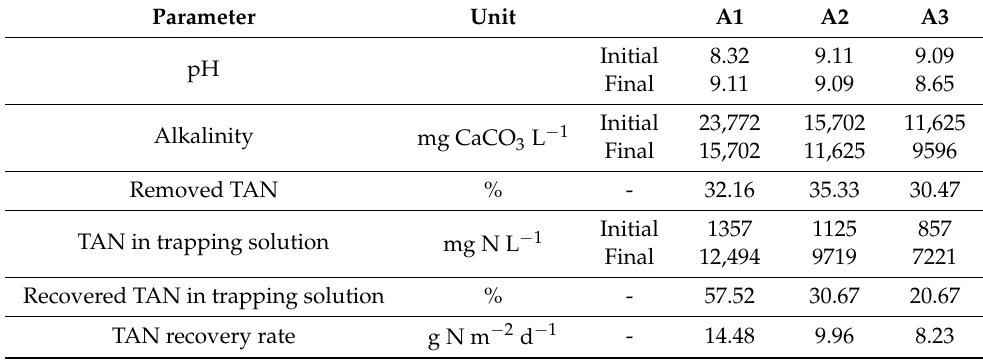
Table 3. Changes in chemical characteristics of digestate during Experiment